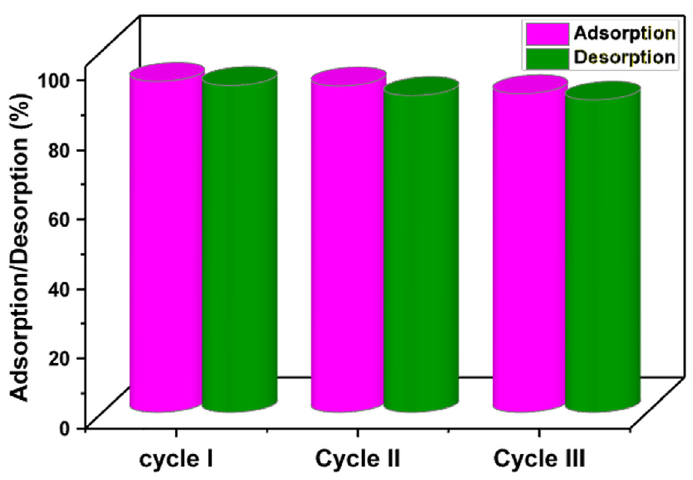
Figure 10. Reusability of the MMIP adsorption/desorption percentages of ciprofloxacin during three cycles. (Reaction conditions: contact time (15 min), solution pH:7, adsorbent dosage (3 mg), initial concentration (100 mg/L) solution volume: 10 mL. T (298 K)).